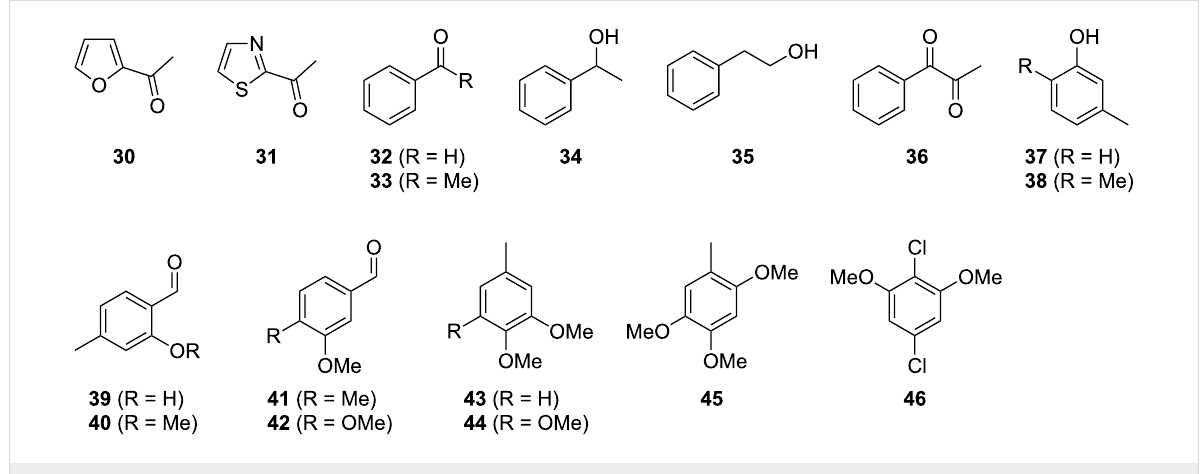
Figure 7: Volatiles from Hypoxylon macrocarpum .